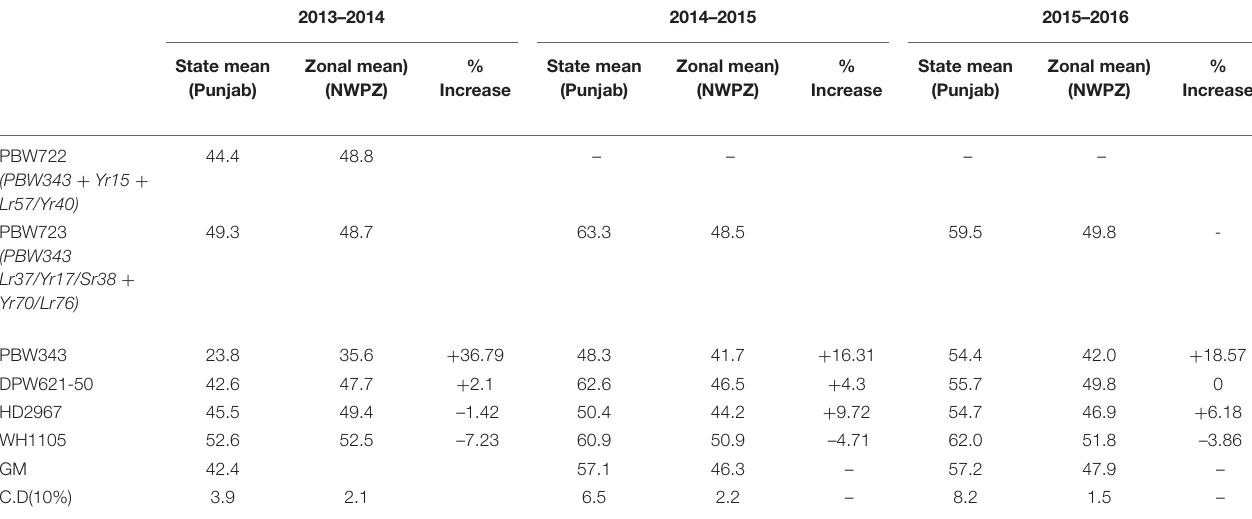
TABLE 5 | Yield performance (quintals/hectare) of PBW723 in SPL-MABB trials at different locations.